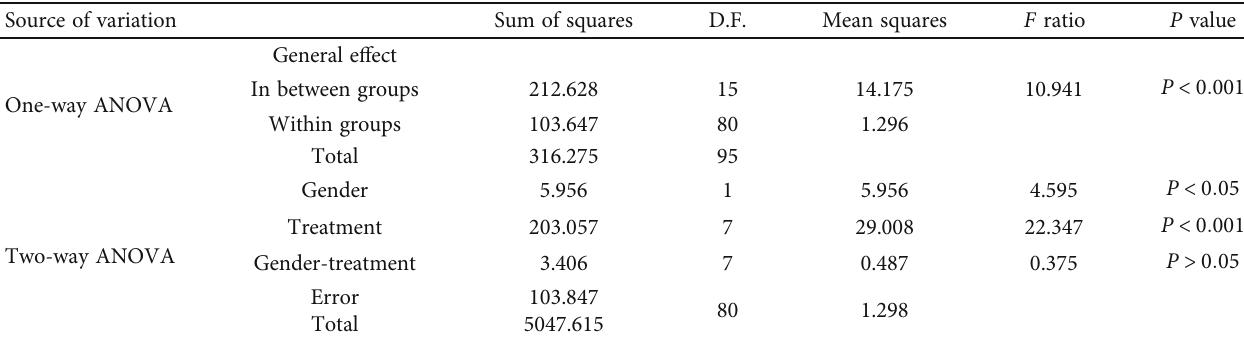
Table 11: One-way and two-way analysis to test the e ff ect of gender, treatment, and their interactions on SOD activity in rats. Source of variation Sum of squares